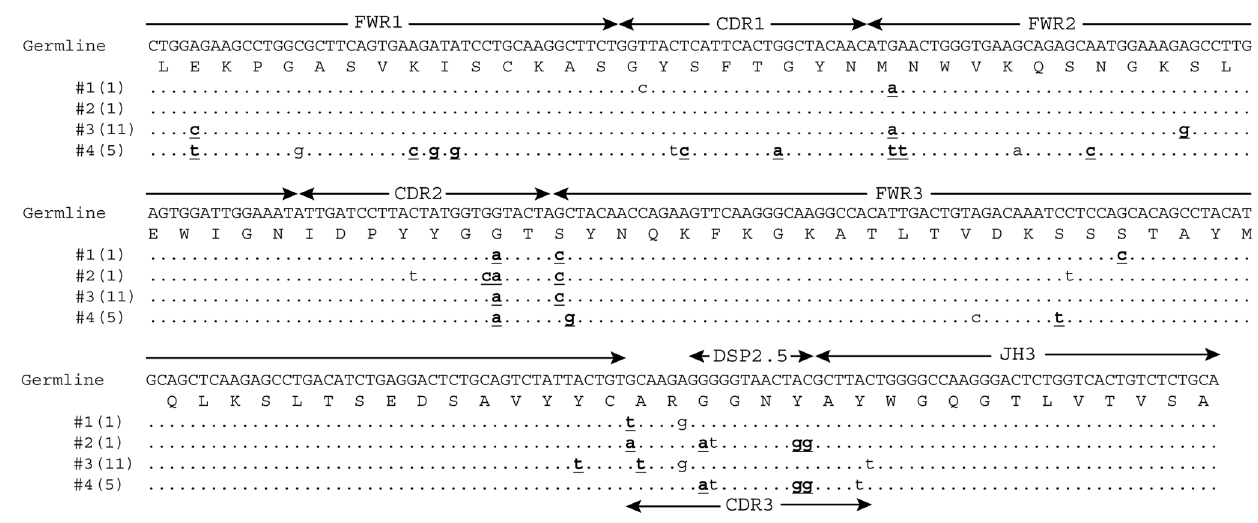
Figure 2. Representative IgAT analysis for V H clonotypes. Four unique J558.12/DSP2.5/JH3 DNA sequences were segregated into 4 clonotypes using IgAT. Germline sequence was obtained by manually juxtaposing the available germline J558.12 sequence (GenBank: AF303843.1) with the DSP2.5/JH3 sequence derived from the first sequence in the alignment (i.e. clonotype 1).